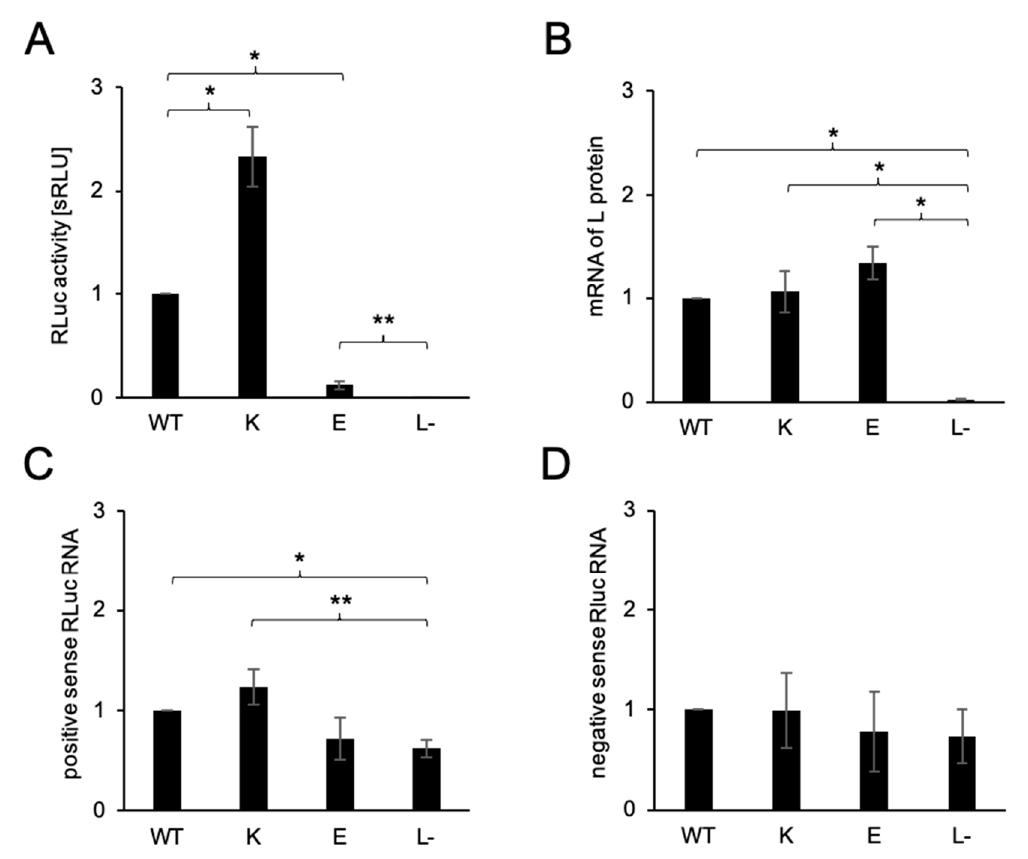
Figure 3. qPCR assay of RNAs under the minigenome condition ( A ) The polymerase activity of the L protein variants, WT, N1891K, N1891E, and L − (mock), was measured prior to the qPCR assay. The activities of RLuc standardized to the FLuc activity are shown in the bar graph (mean and standard deviation of the standardized relative light units [sRLU] as a fold-change value compared to WT in three independent assays) with the error bars representing the standard deviations of the means and the asterisks indicating a significant difference from WT or L − (two-tailed, one sample t-test), as follows: * p < 0.01, ** p < 0.05. The RNA samples were obtained from the same samples used for the minigenome assay. The extracted RNAs were used for RT-PCR following the qPCR assay. The amount of the L protein mRNA ( B ), positive strand Rluc RNA ( C ), and negative strand Rluc RNA ( D ) were divided by the value of FLuc to standardize the differences in transfection efficiency and cell density and are shown as the mean with standard deviation of the ratio to WT in three independent assays. Error bars represent the standard deviations of the means, and the asterisks indicate significant differences from L- (a two-tailed one sample t -test), as follows: * p < 0.01, ** p < 0.05.